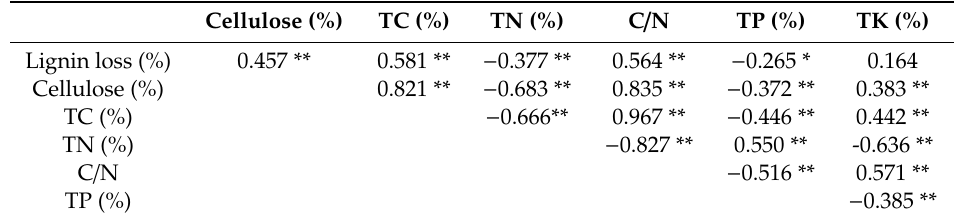
Table 4. Pearson correlation coe ffi cient among BGR’s properties. Significant correlation is shown at p < 0.05 (*) and p < 0.01